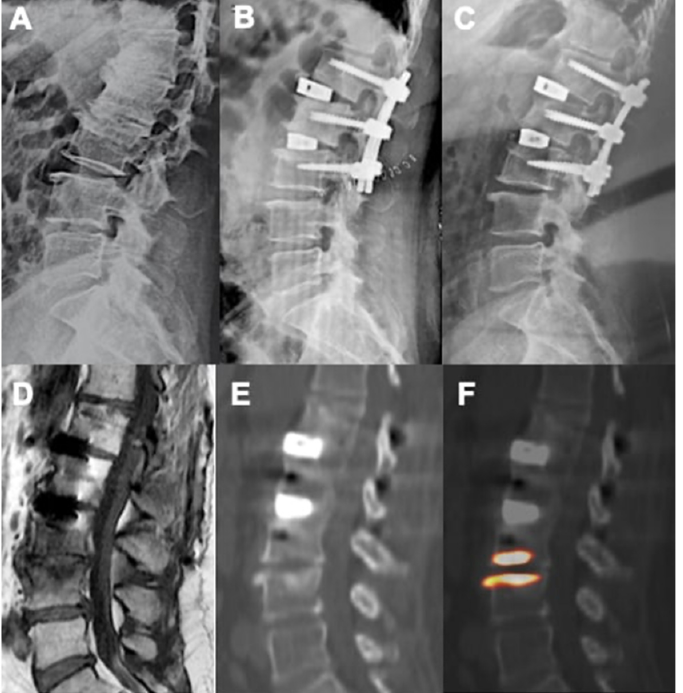
Figure 5. Pre-operative standing x-ray ( A ), immediate postoperative ( B ), and 58 weeks follow-up ( C ) showing good sagittal correction after L1-L2 and L2-L3 XLIF surgery. PET ( F ) and CT ( E ) images showed no activity at the level of the implanted vertebral plates suggesting a proper integration with the bone. Appearance of L3-L4 activity was related to the occurrence of degenerative junctional pathology as also shown by T1-weighted MRI sequences with Modic I signal ( D